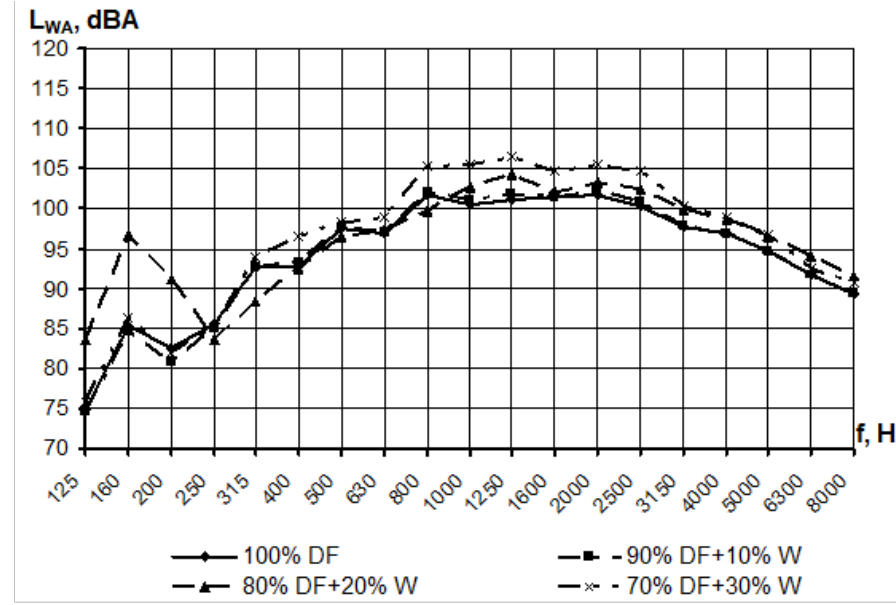
Figure 7. The sound power spectra of the engine when working on diesel fuel and water–fuel emulsions at n = 2400 rpm.